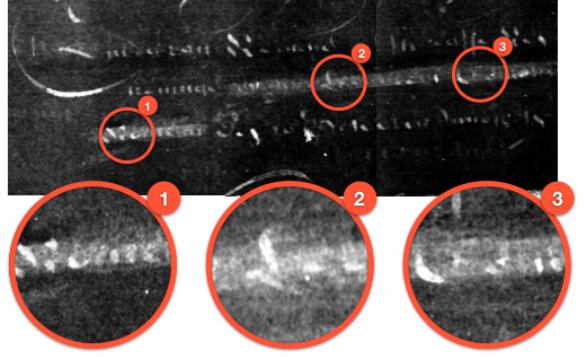
Figure 13. Zoom-in on the three initials of the